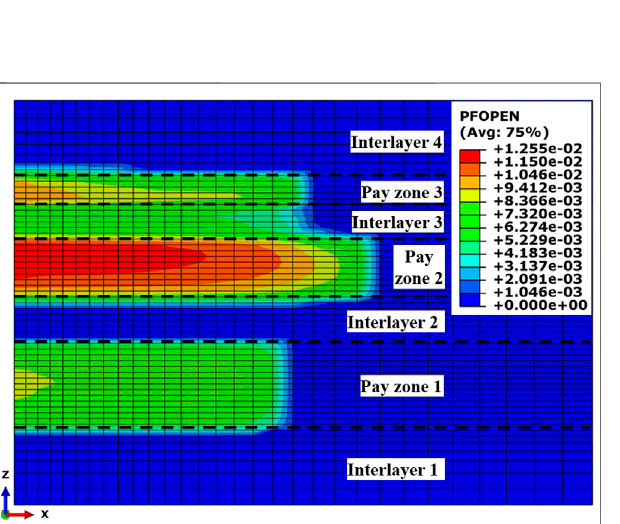
FIGURE 10 | Hydraulic fracture geometry in the model with pay zones sharing the same injection rate.